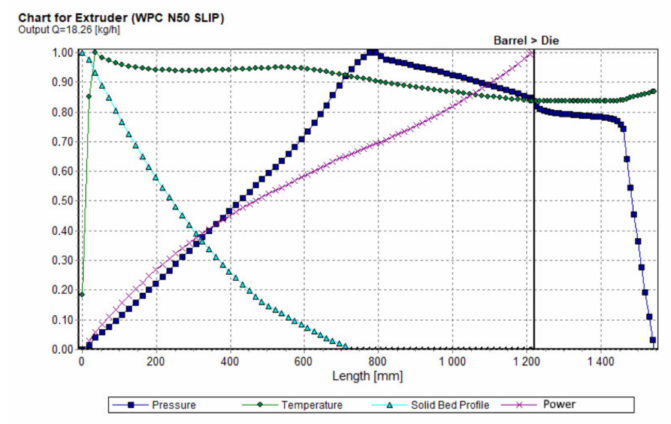
Figure 11. Overall extrusion process characteristics.